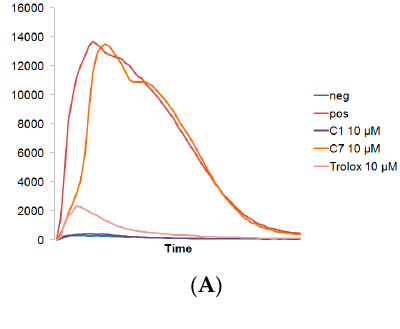
Figure 4. Cont. Figure 2.